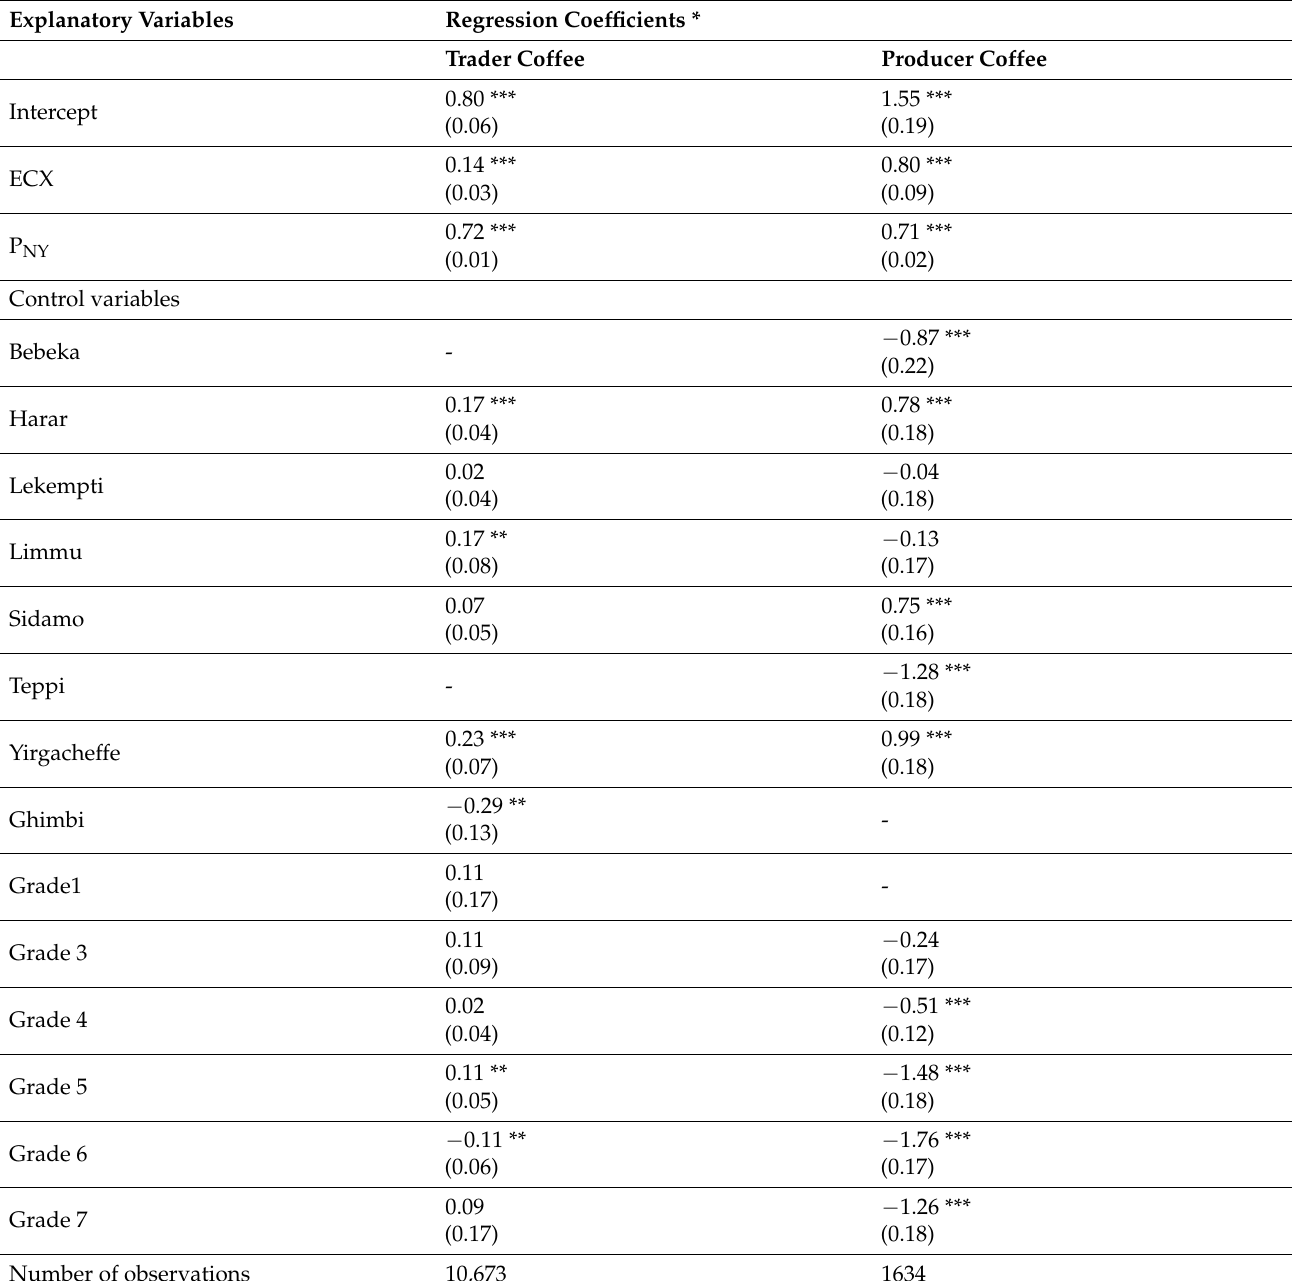
Table 3. Ordinary least squares